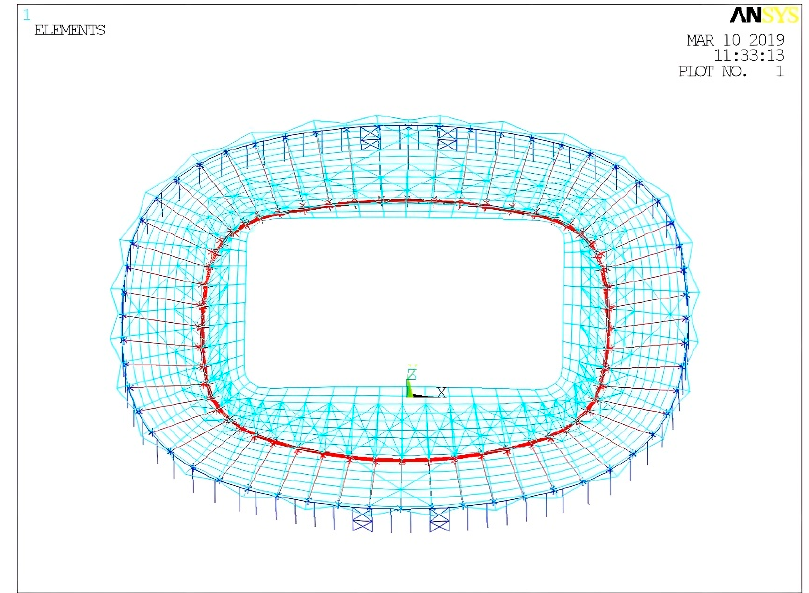
Figure 8. Finite element model of whole structure.